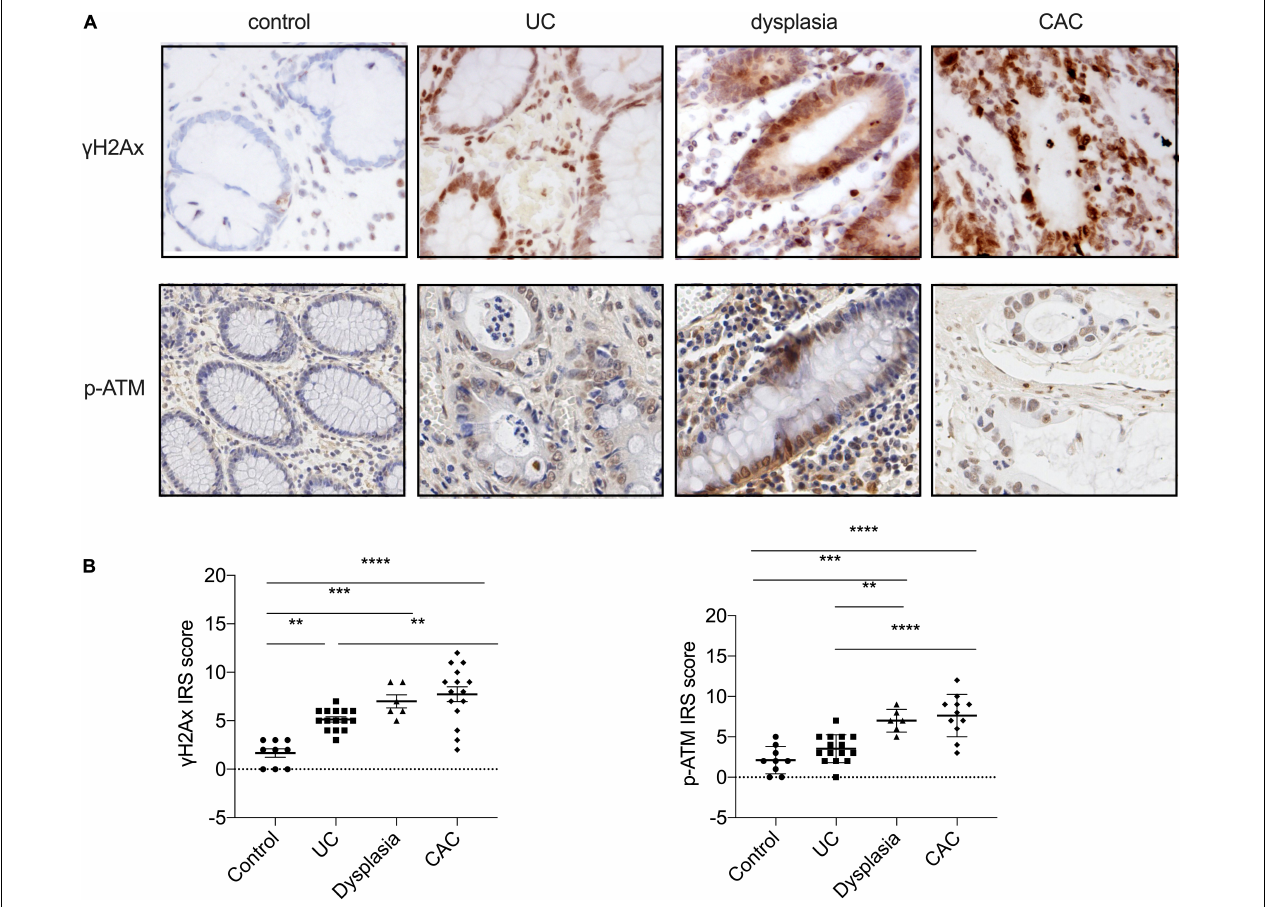
FIGURE 1 | Ulcerative colitis development is associated with genome instability. (A) The expression of S139-phosphorylation of histone H2Ax ( γ H2Ax) and ATM phosphorylation ( p -ATM) levels were determined by immunohistology assay in healthy controls, patients with UC or dysplasia, and patients with colitis-associated cancer (CAC). (Magnification, × 20.) (B) Statistical analysis of γ H2Ax and ATM phosphorylation levels determined by immunohistology assay. * p < 0.05, ** p < 0.01, *** p < 0.001, **** p <